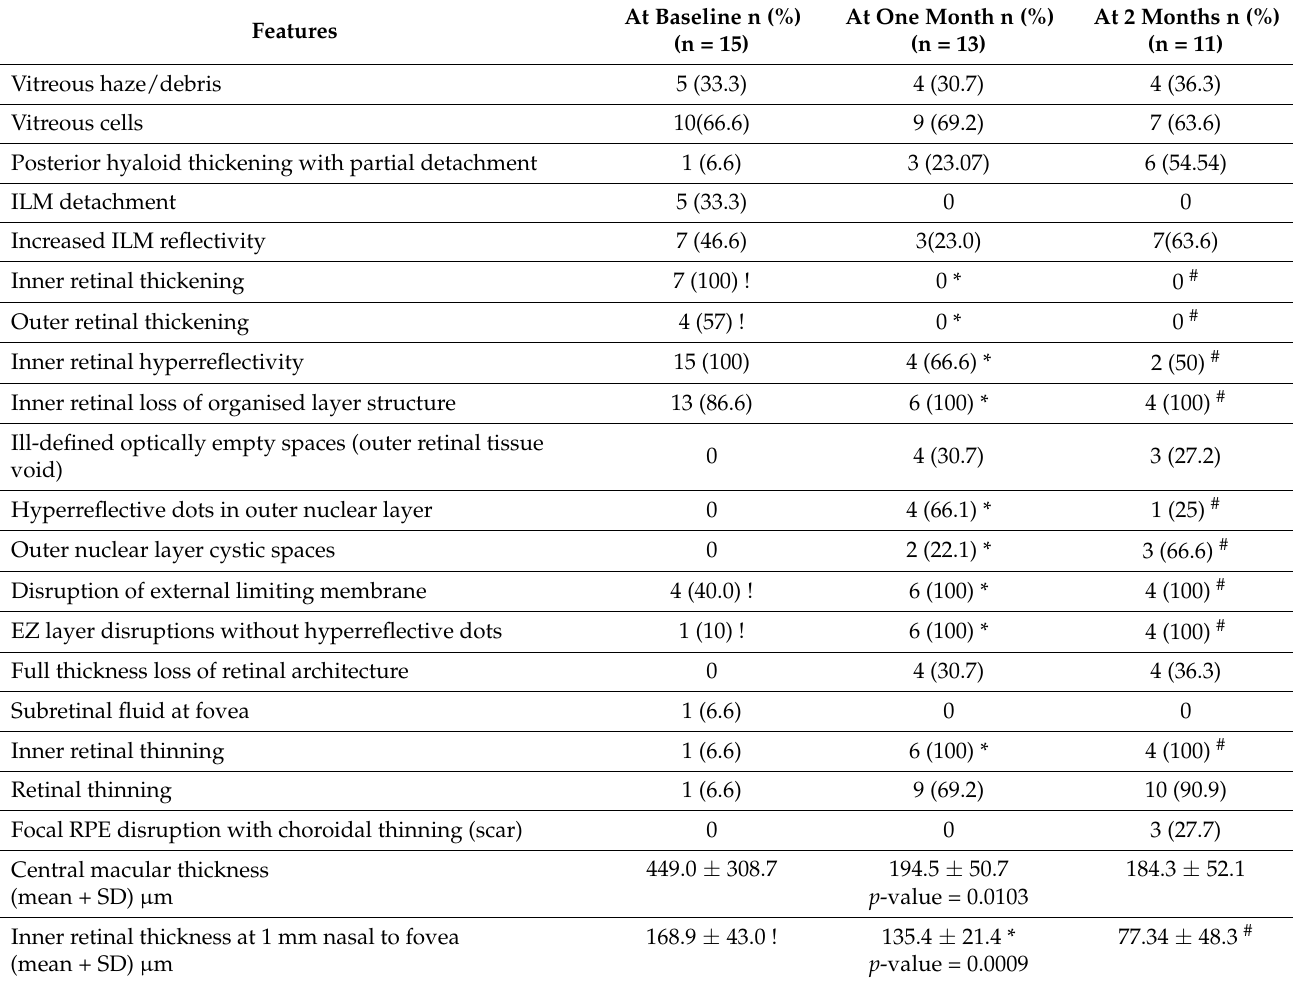
Table 3. Prevalence of OCT findings in patients with vison-threatening